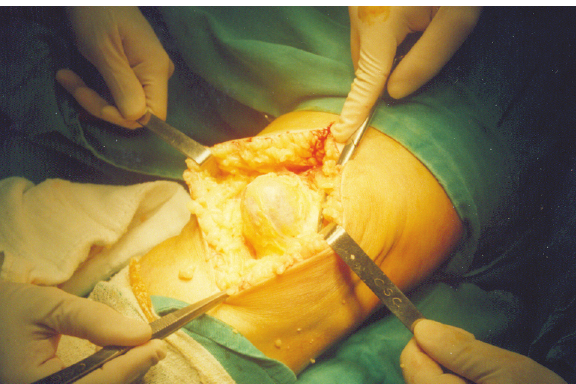
Figure 5 - Cyst resection using the open approach meniscal tear and accumulates outside the joint capsule 10